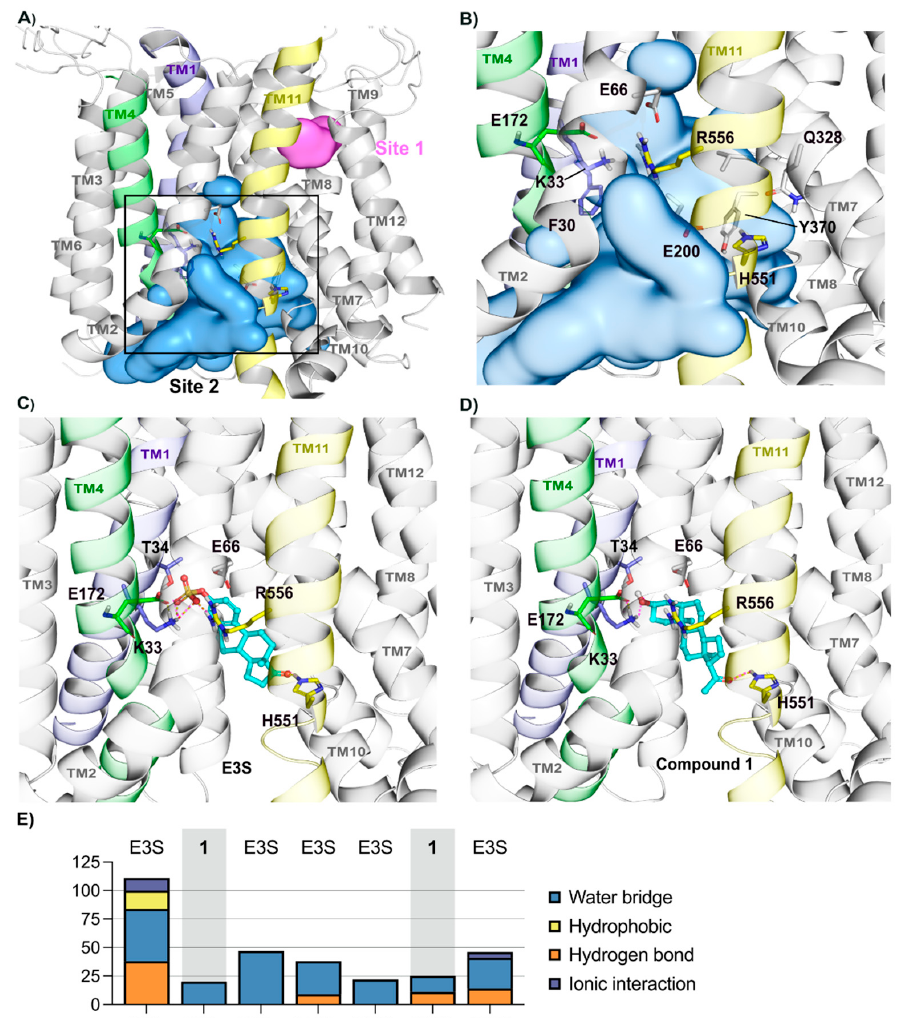
Figure 5. Human OATP1A2 homology model and its conserved potential binding pocket. Overview of the OATP1A2 model highlighting the volume of the two predicted binding pockets (Site 1, in pink, and Site 2, in blue) ( A ) followed by an insight of Site 2 ( B ). Predictions were performed using SiteMap and pockets were selected according to their druggability score, as described in the methods section. The compounds E3S and 1 were docked and simulated within the Site 2 and representative frames are depicted in ( C ) E3S and ( D ) compound 1, where one can observe the main residues with stable interactions in the simulations lying in the transmembrane helices 1 (highlighted in light purple), 4 (in green), and 11 (in yellow). ( E ) Individual residues and their interaction frequencies (% of simulation time) for each compound are shown as bar plots, where each interaction type is colored differently.